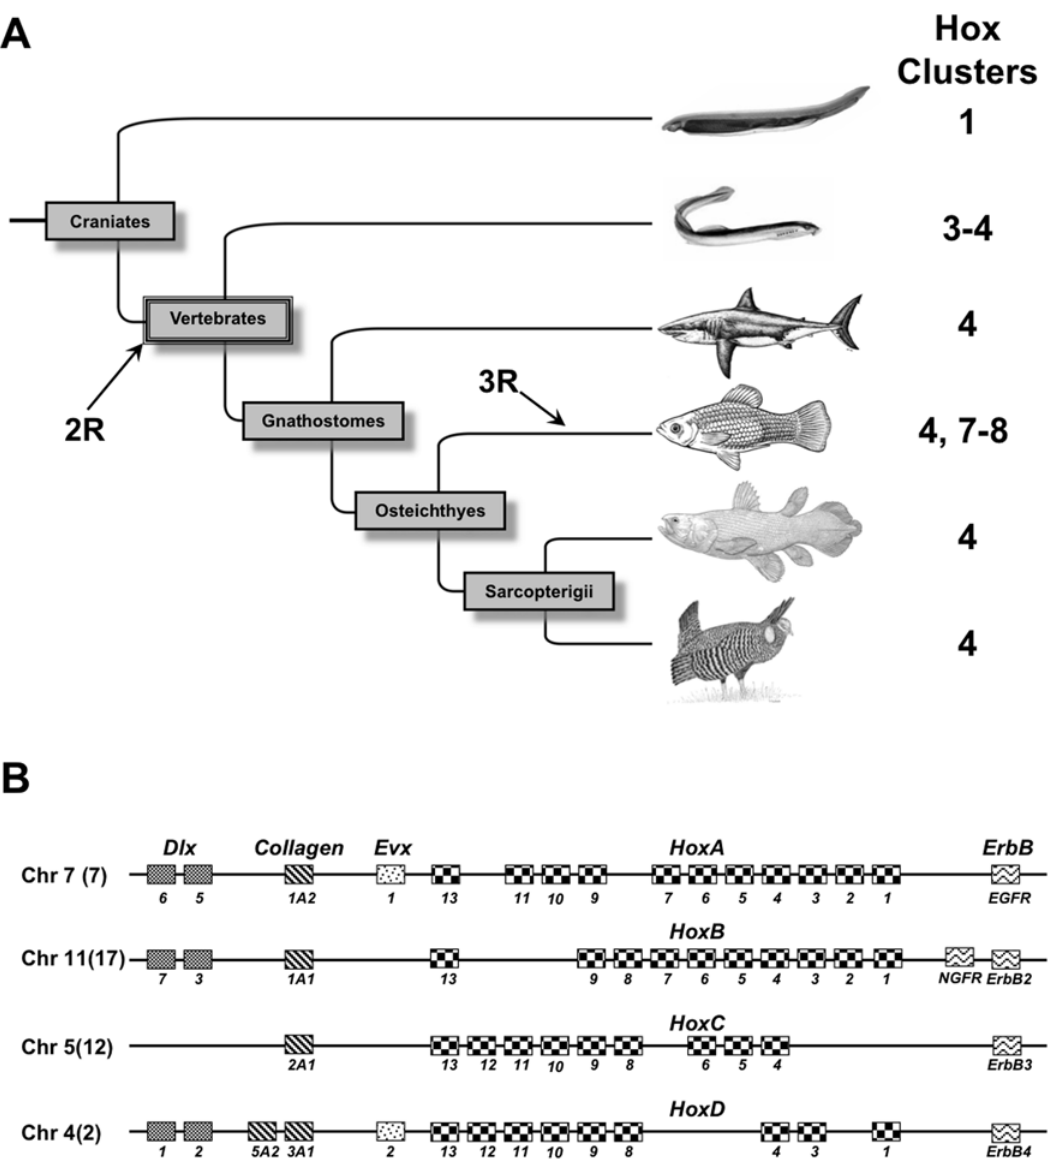
Figure 1. A, The phylogeny of Craniates showing the phylogenetic locations of genome duplications. Note there was an additional genome duplication in fish (3R). The number of Hox clusters in each group is shown on the right. B, Schematic representation of the ‘‘core’’ Hox paralogon in the ancestral vertebrate. The chromosomal location (Chr # ) of the paralogons in the inferred ancestral vertebrate are shown. Gene family names are given above, and gene names are given below each